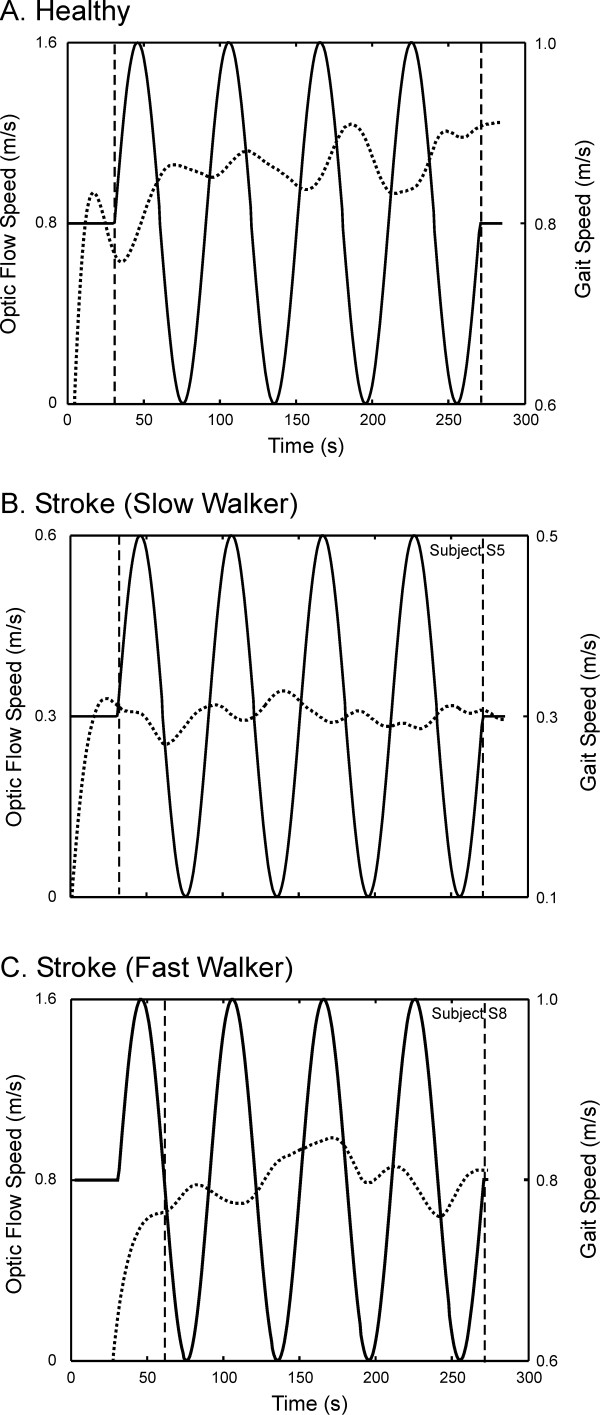
Modulation of gait speed (dotted lines) as a function of optic flow speed (plain lines) in a healthy subject (A) and subjects with stroke presenting with a slow (B) and a faster walking speed (C). Data were analyzed once the subjects reached their comfortable speed, as indicated by the vertical dashed lines. Left and right y-axes are for optic flow speed and gait speed, respectively. Note the different y-axis scales amongst the subjects.